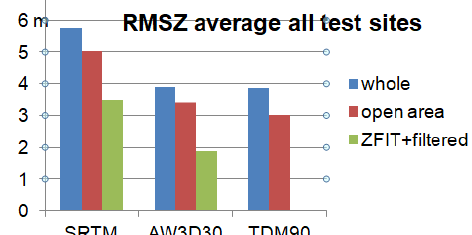
Figure 21. Average root mean square of all test sites and with test site Mountain for terrain inclination below 0.1